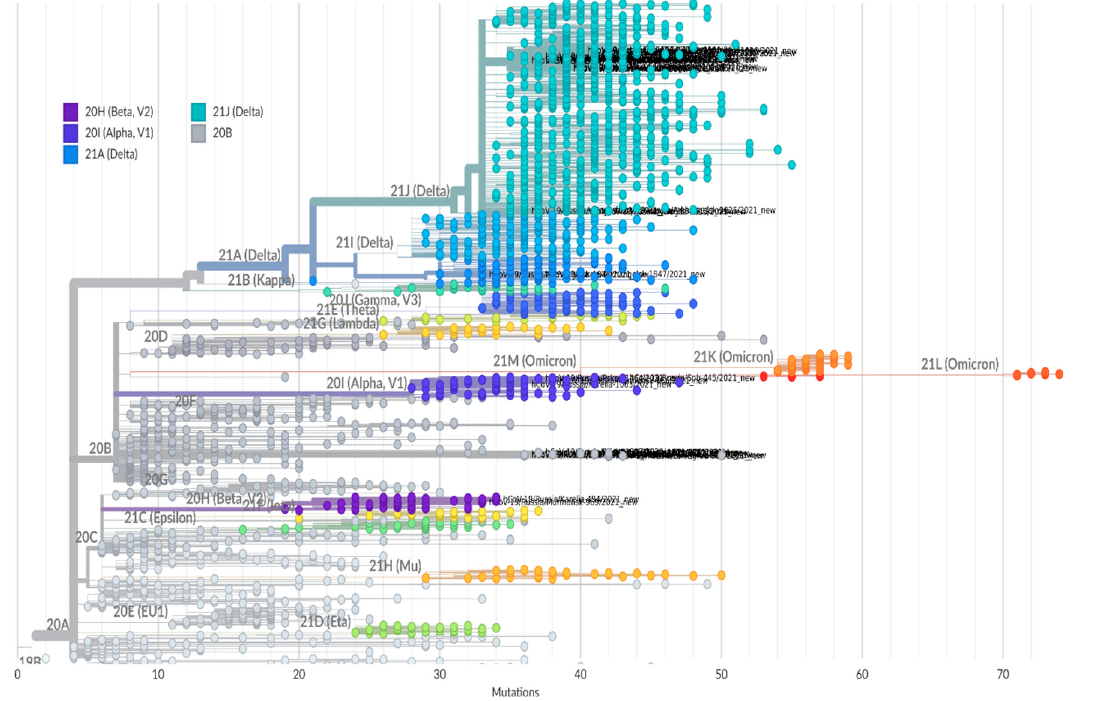
Figure 8. SARS-CoV-2 phylogenetic tree reconstruction based on Nextclade tools. Branches are labeled and colored by clade according Nextstrain nomenclature (legend top left). Sequences obtained in this study are highlighted with their names in black. The scale bar at the bottom indicates the number of nucleotide differences between each sample and the Wuhan-Hu-1/2019 reference sequence (GenBank: